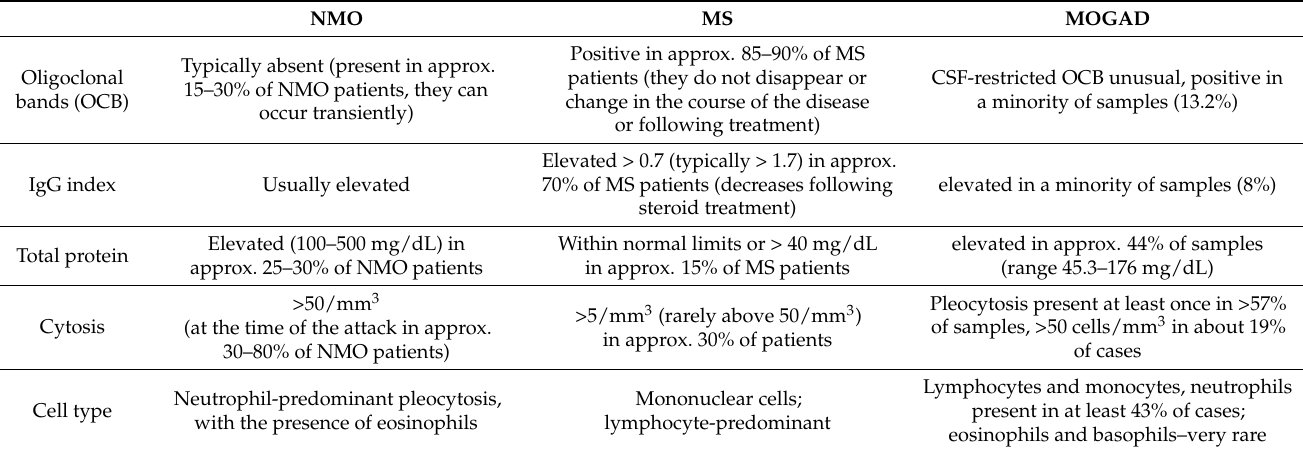
Table 1. Cerebrospinal fluid analysis in patients with MOGAD, NMOSD, and MS [56–59]. NMO MS